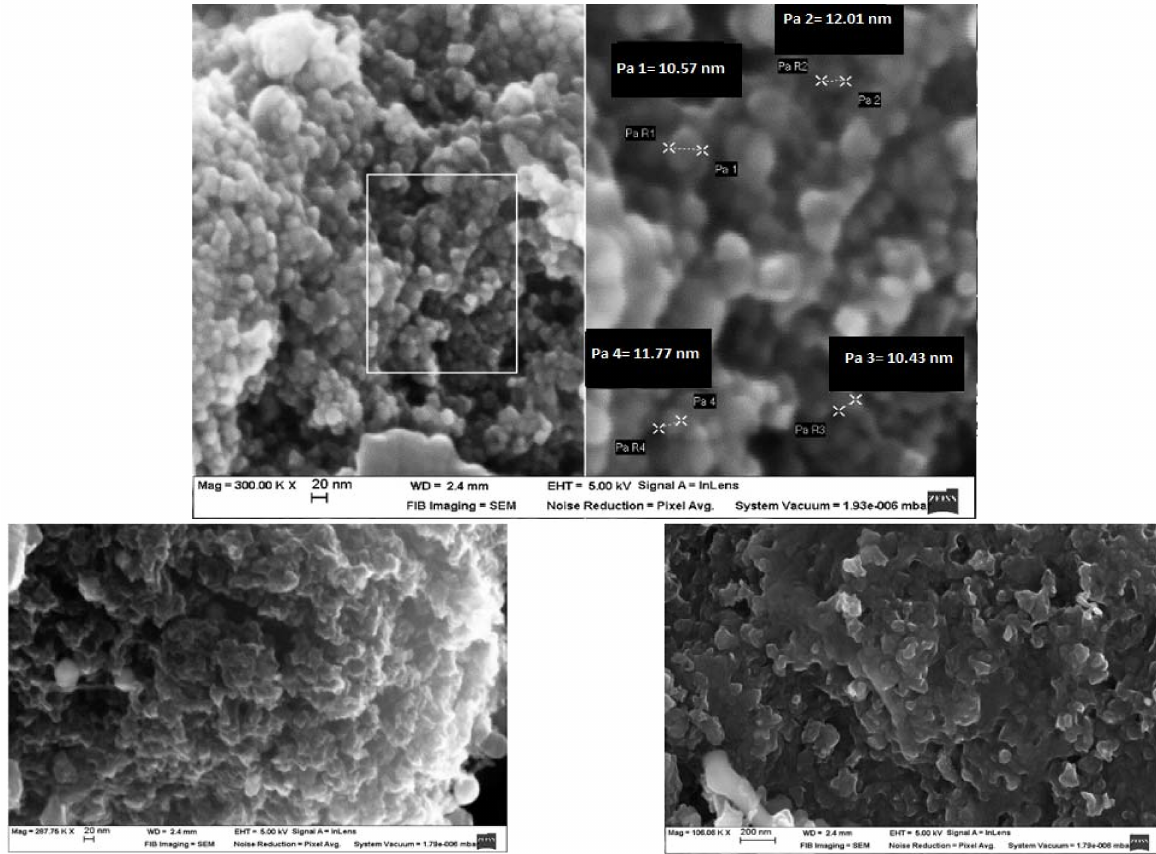
Figure 7. Scanning electron microscopy of the X2 variant (RF gel impregnated in carbon felt followed by